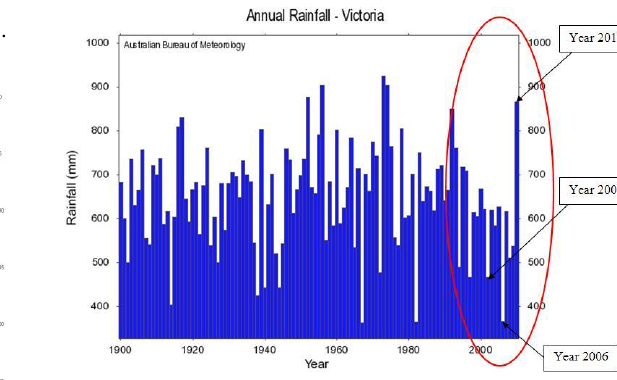
Figure 9. Annual rainfall in Victoria in the last 100 years (BOM,